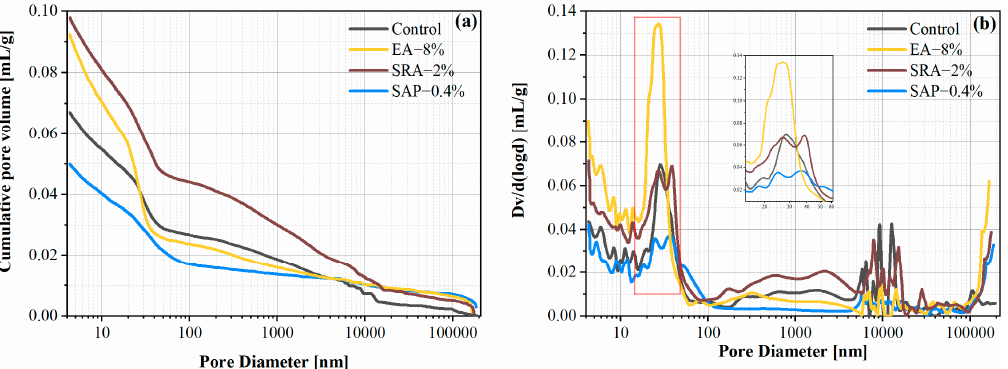
Figure 12. Influence of the different shrinkage reducing components on cement mortars: ( a ) the cumulative pore volume and ( b ) the pore size distribution. Table 4. Pore volume and porosity of hardened mortars samples.